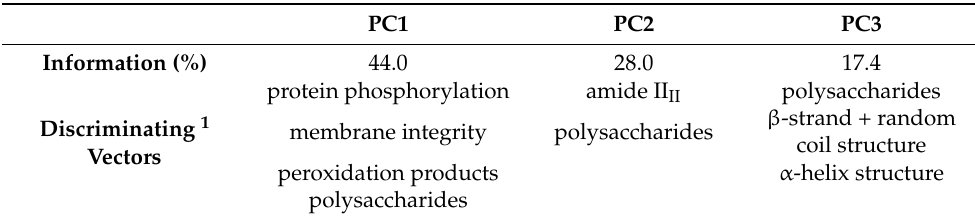
Table 2. Parameters (Principal components and discriminating variable vectors) determined through